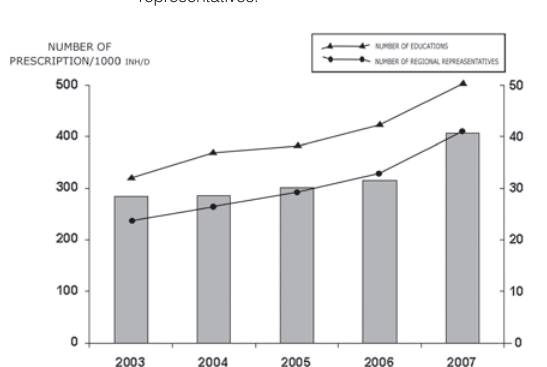
Figure 6. Comparison number of prescription antihypertensive drugs and number of educationes and regional representatives.